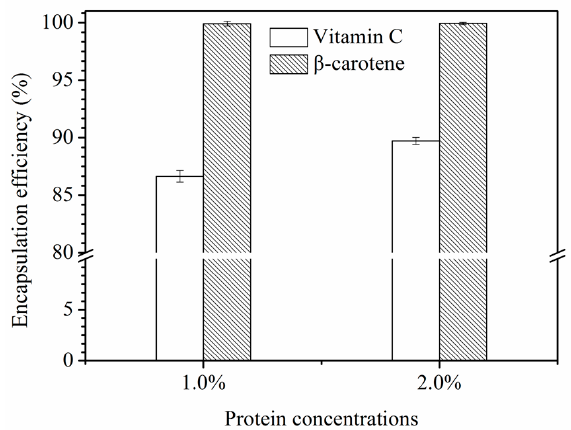
Figure 8. Encapsulation yield of β -carotene and vitamin C in a double emulsion.